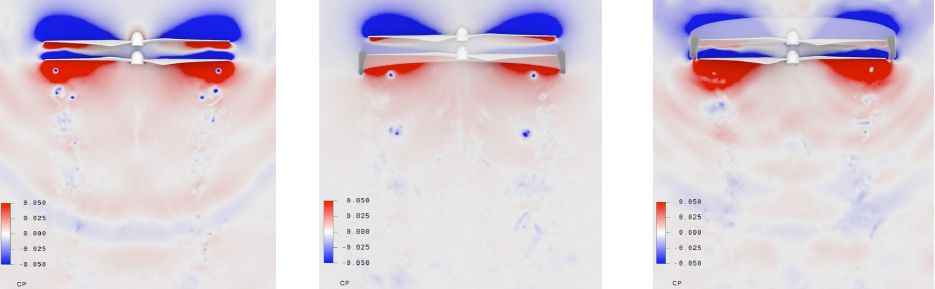
Figure 1. Pressure fluctuations for different configurations (counter-rotating). Left: open rotors, Center: duct around lower rotor, and Right: duct around upper rotor [10].